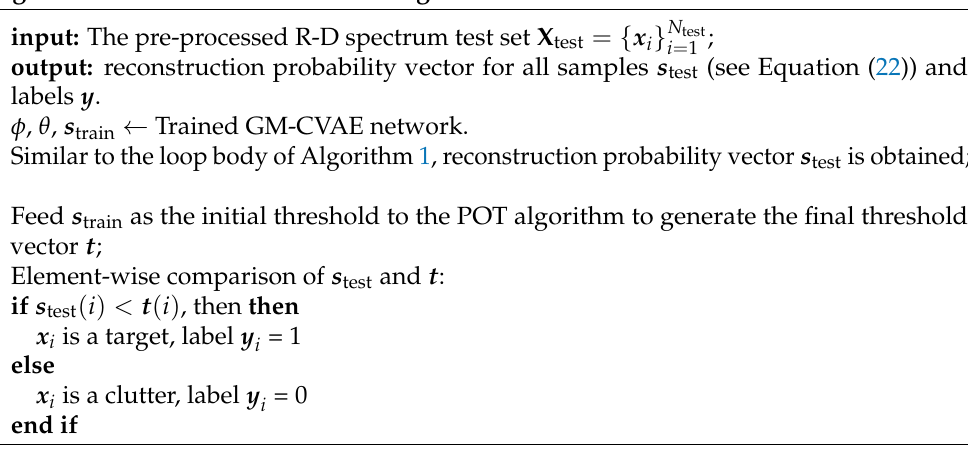
Algorithm 2 : GM-CVAE Detection